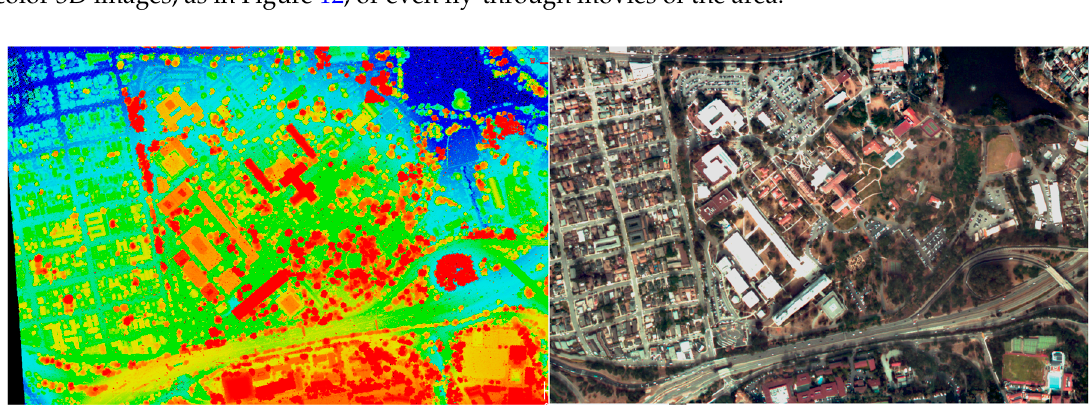
Figure 11. HRQLS-1 lidar image and digital color photograph of the area surrounding the Naval Post Graduate School in Monterey, California.